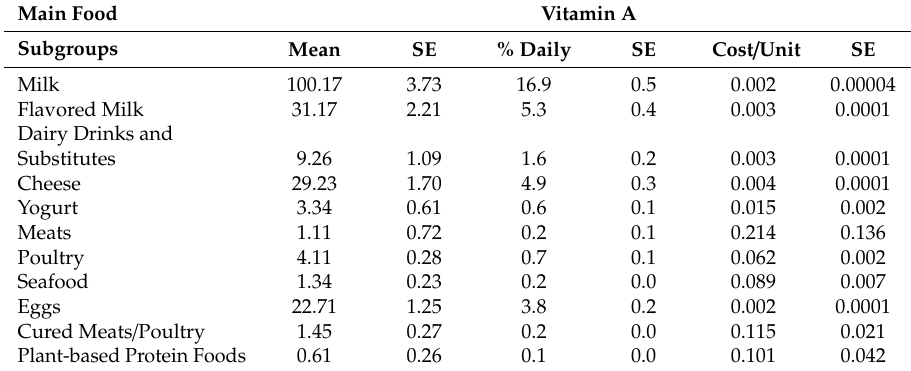
Table 13. Percent daily vitamin A (RAE mcg) and cost ($) of vitamin A from eggs in children, compared to USDA protein food subgroups.